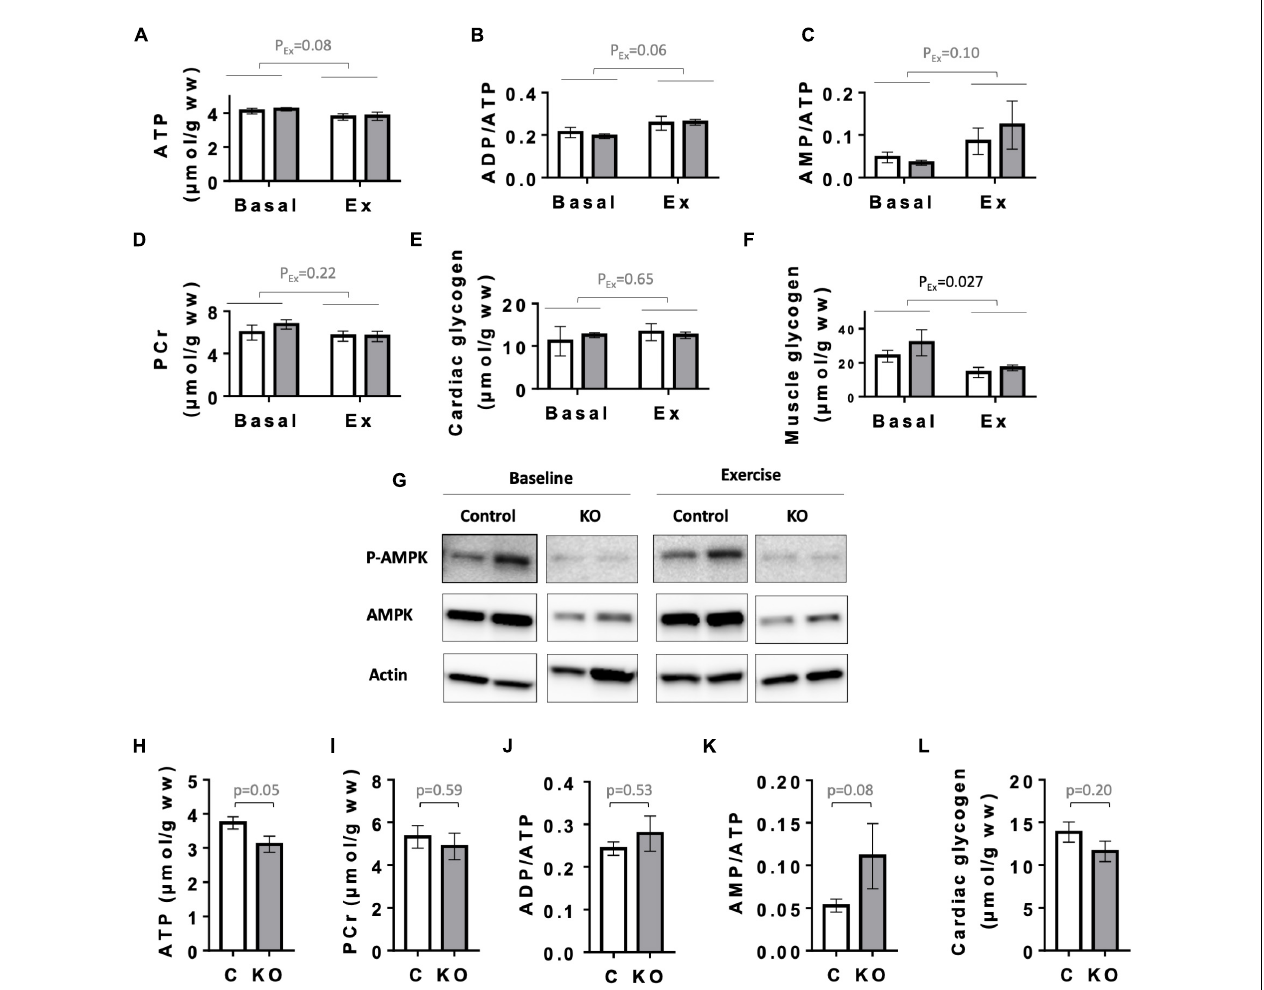
FIGURE 7 | Energy status of control and AMPK α 1 α 2-KO mice. (A–E) Basal and post-exercise levels of cardiac energy metabolites 24 weeks after tamoxifen administration: ATP (A) , adenine nucleotide ratios ADP/ATP (B) , AMP/ATP (C) , phosphocreatine (D) , and glycogen (E) . (F) Basal and post-exercise glycogen in skeletal muscle. In panels (A–F) all mice were subjected to the same running protocol, i.e., running of moderate intensity at 18 m/min without incline for 30 min. (G) Phosphorylation of AMPK α (Thr172) in hearts analyzed in panels (A–F) ; for each antibody, all signals originate from the same blot. (H–L) Cardiac energy metabolites 52 weeks after tamoxifen administration: ATP (H) , phosphocreatine (I) , adenine nucleotide ratios ADP/ATP (J) , AMP/ATP (K) , and cardiac glycogen (L) . Control (white bar), KO (gray bar). Data are presented as means ± SEM. In panels (A–F) n = 4 control and 3 KO (baseline), 5 control and 4 KO (exercise). Data were analyzed by 2-way ANOVA and the resulting significance values are given only for the main effects of exercise P Ex ; the effects of genotype and interaction between genotype and exercise are not significant for all parameters in panels (A–F) and are not reported. In panels (H–L) , n = 9 (H–K) , 13–17 (L) and comparisons were performed either using t -test or in panels (J,K) Mann–Whitney test; the resulting p -values are